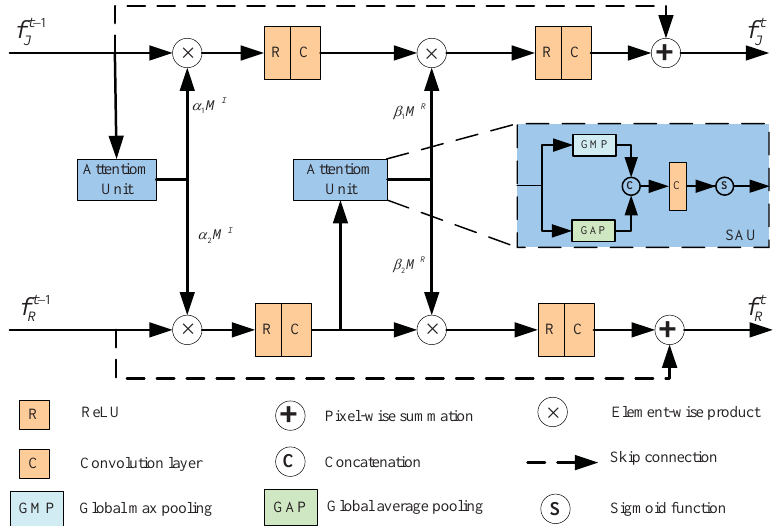
Figure 5. The architecture of the proposed hybrid-modulated module (HMM). Here, the spatial attention unit (SAU) is an example of the attention unit (AU).